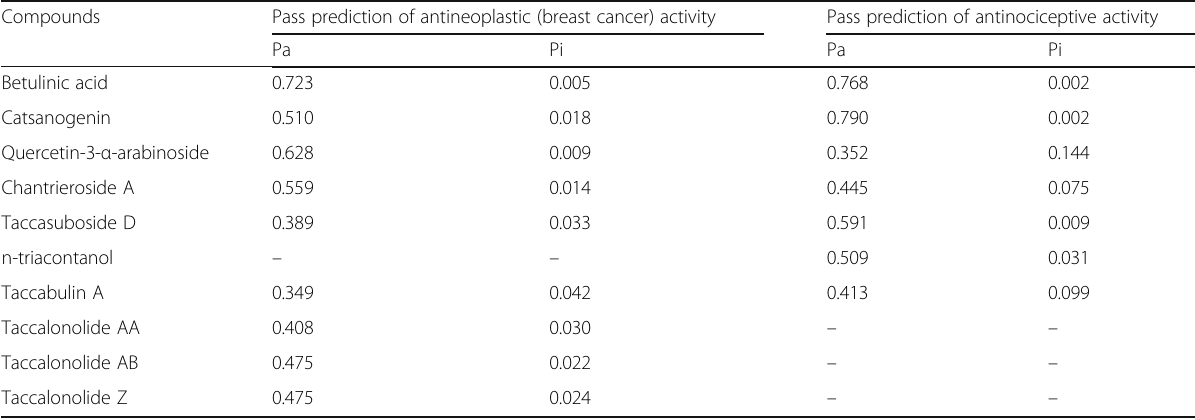
Table 6 Pass prediction of betulinic acid, catsanogenin, quercetin-3- α -arabinoside, chantrieroside A, taccasuboside D,